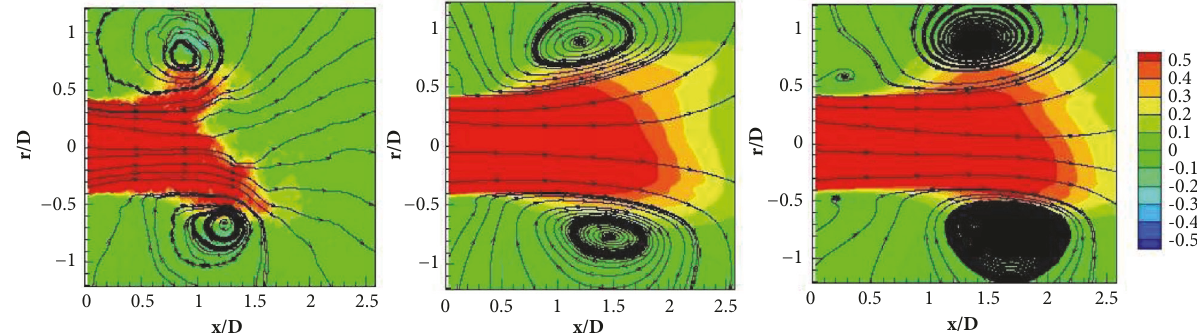
Figure 8: Instantaneous pseudo-streamlines and streamwise velocity contours for a representative snapshot ( 𝑡 = 𝑇/9 ) in the injection phase, showing the original PIV data (left plot) and the reconstructions using DMD-700 for low (middle plot) and high (right plot) accuracy.